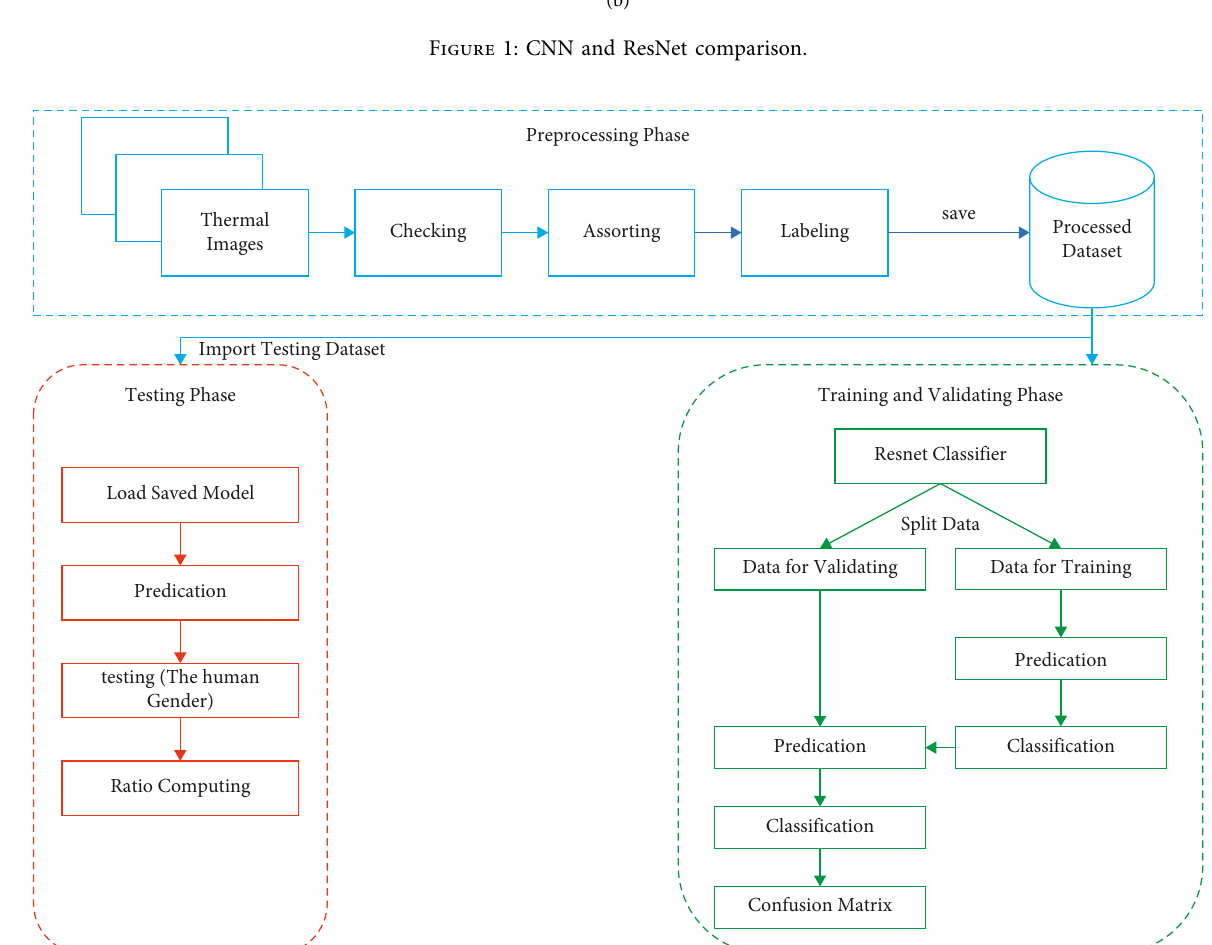
Figure 2: Block diagram of the IRT_ResNet proposed